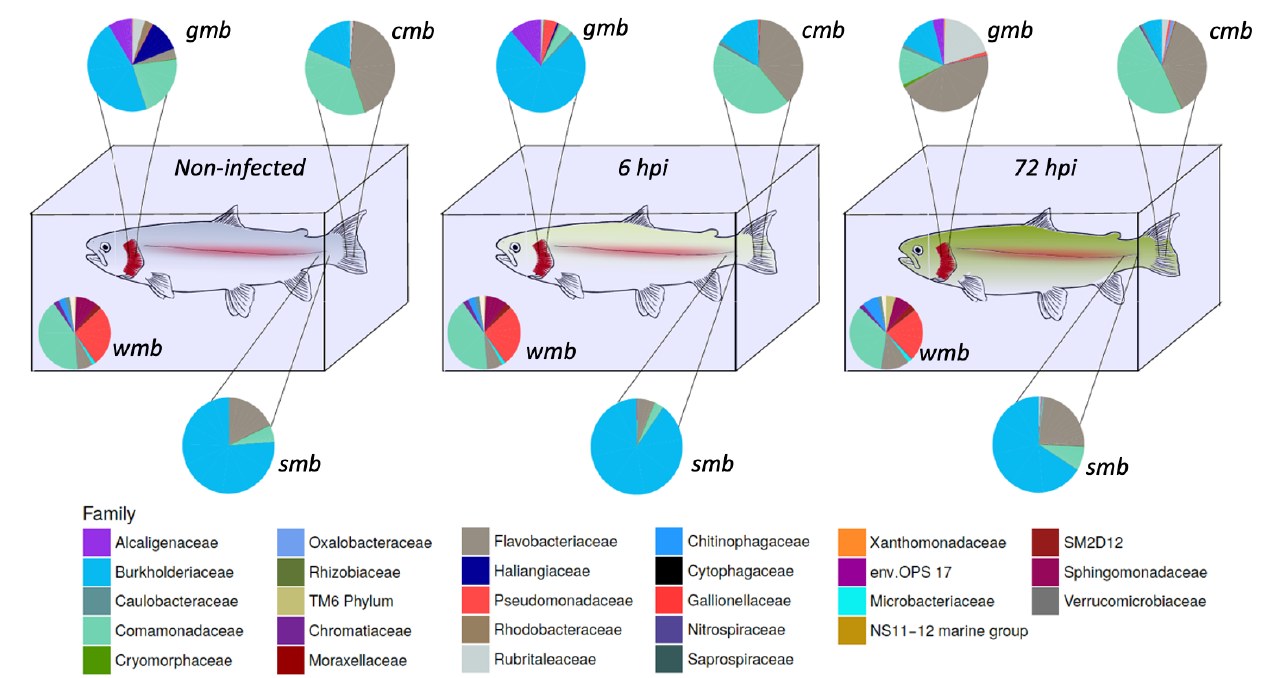
Figure 1. Bacterial composition of the core microbiota from different epithelia (gills: gmb ; skin: smb ; and caudal fin: cmb ) and water before (before the infection: blue fish on the left side) and after bacterial challenge (6 h post-infection: yellow fish in the middle; and 72 h post-infection: green fish on the right side) with Aeromonas salmonicida achromogenes . OTUs were merged by family in order to keep the maximum information while reducing the noise from OTU number and are indicated under the draw.